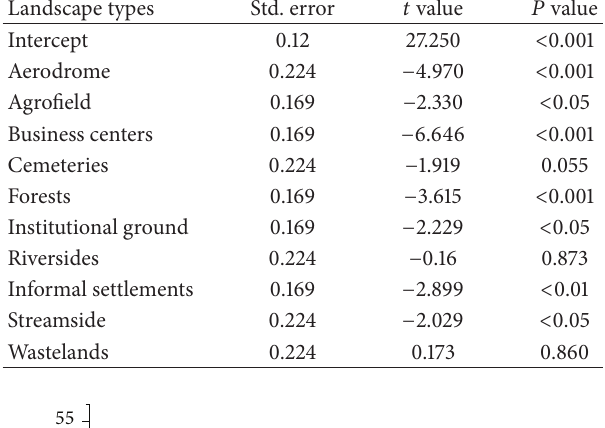
Figure 4: Mean number of bird species observed during plot visits